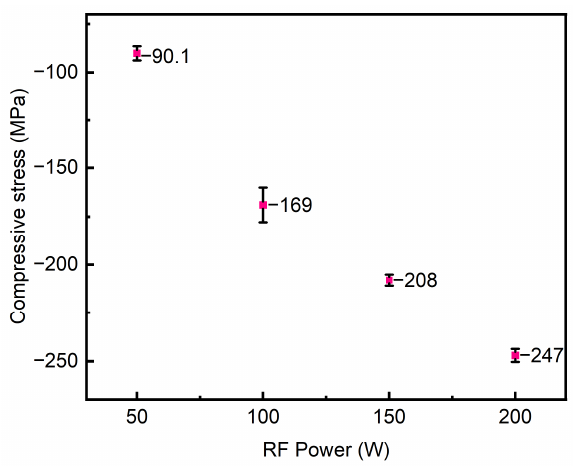
Figure 8. Compressive stress as a function of the RF power.